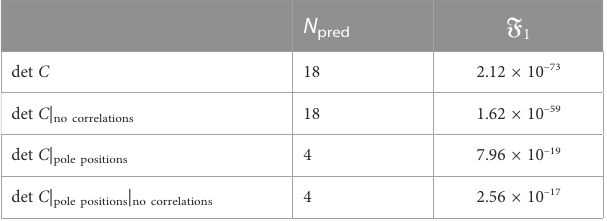
TABLE 2 The generalized variance, det C , calculated from the covariance matrices for F 1 . The second to fourth rows show generalized variances calculated for covariance matrices that have been reduced to isolate the effects of various correlations. Number of predicted resonance parameters is denoted N pred